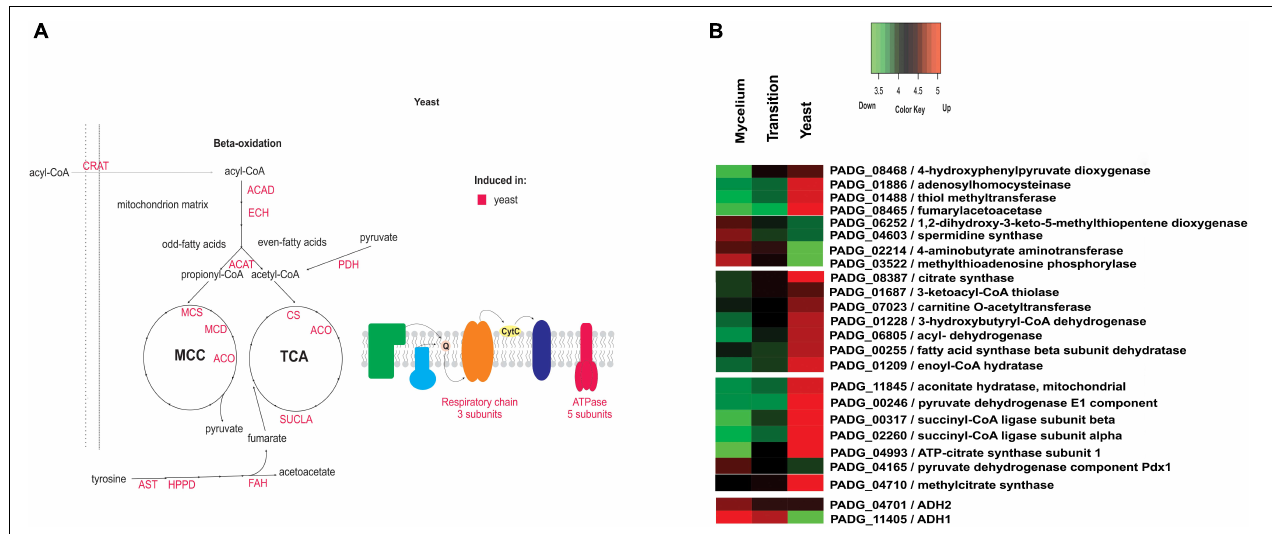
FIGURE 5 | Schematic diagram of the metabolic processes differentially expressed in yeast cells and heatmap of proteins in mycelium, mycelium-to-yeast transition, and yeast cells. (A) The figure summarizes the data obtained from proteomic analysis; enzymes are listed as follows: Acad, acyl-CoA dehydrogenase; ECH, enoyl-CoA hydratase; ACAT, ketoacyl-CoA thiolase; MCS, methylcitrate synthase; MCD, methylcitrate dehydrogenase; ACO, aconitase; CS, citrate synthase; SUCLA, succinyl-CoA ligase; PDH, pyruvate dehydrogenase; ATPase, ATP synthase; ANT, aspartate aminotransferase; HPPD, hydroxyphenylpyruvate dioxygenase; FAH, fumarylacetoacetase; CRAT, carnitine acetyltransferase; SRM, spermidine synthase; MTAP, methylthioadenosine phosphorylase; MTCBP, 1,2-dihydroxy-3-keto-5-methylthiopentene dioxygenase. (B) The color scale shows the mean of abundance of differentially expressed proteins ( p -value ≤ 0.05). Functional categories were obtained by manual search in the annotation database Pedant (http://pedant.gsf.de/) on MIPS that provides a tool to search the Functional Categories (Funcat 2.0). Red represents significantly higher expression and green represents a significantly low level of